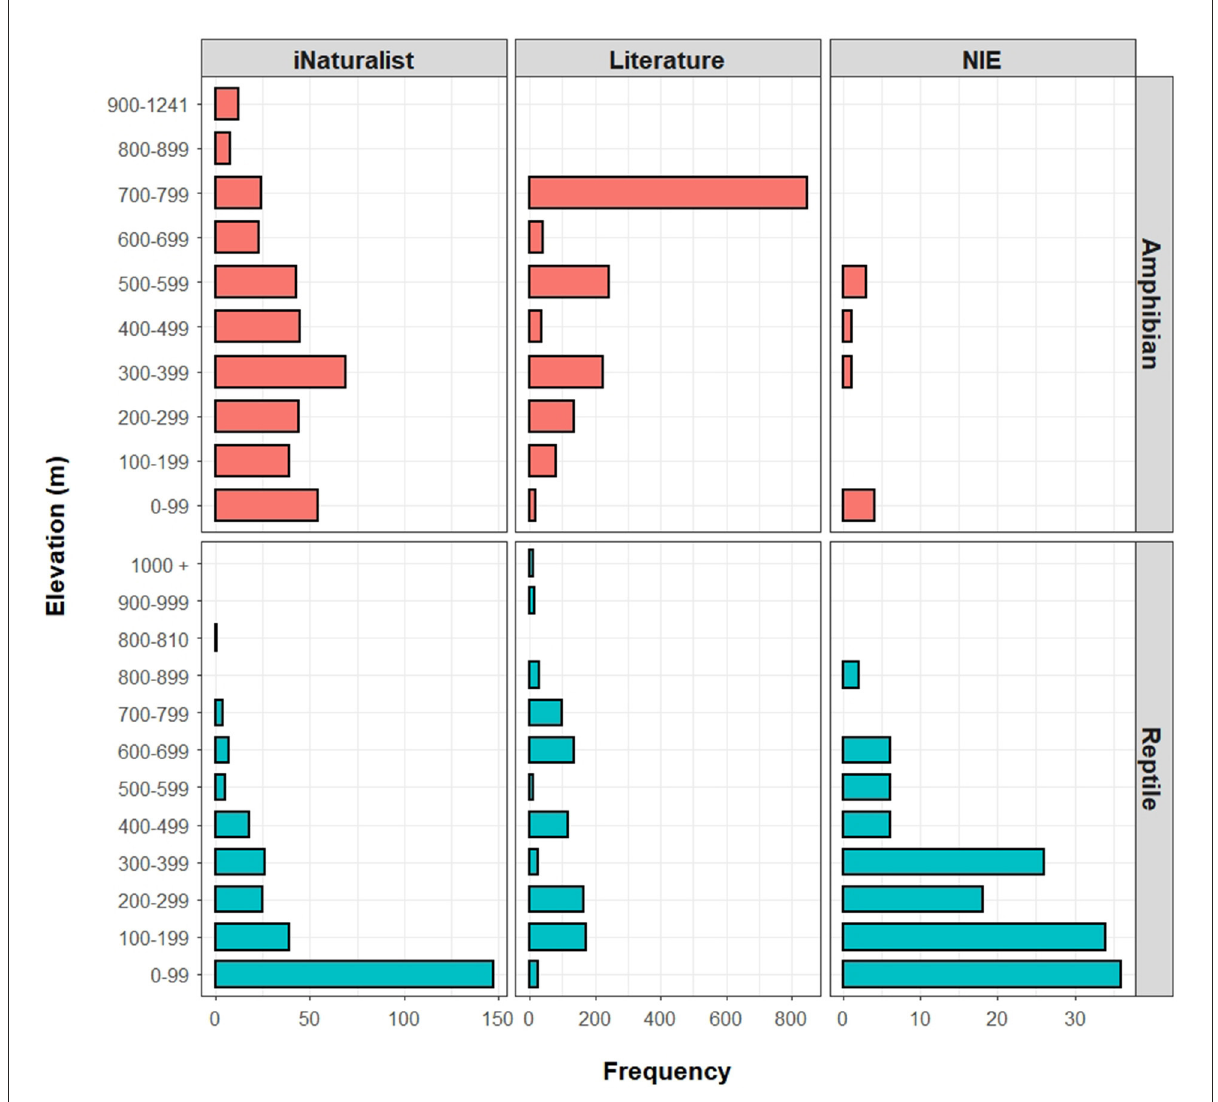
FIGURE9 Elevational distributions of roadkill records compared among the iNaturalist, literature, and governmental (National Institute of Ecology; NIE) data. Regarding the iNaturalist data, the amphibian roadkill frequency was the highest around low to mid elevations, whereas the reptile roadkill frequency was the highest in low elevations, with clear decrease toward higher elevations. The literature-based data shows a different trend, with amphibian roadkill frequency roughly increasing toward higher elevations, and with reptile roadkill frequency showing fluctuating patterns. The sample size of NIE data is insufficient to detect elevational patterns for amphibians, but there is an overall decreasing trend with increasing elevation for